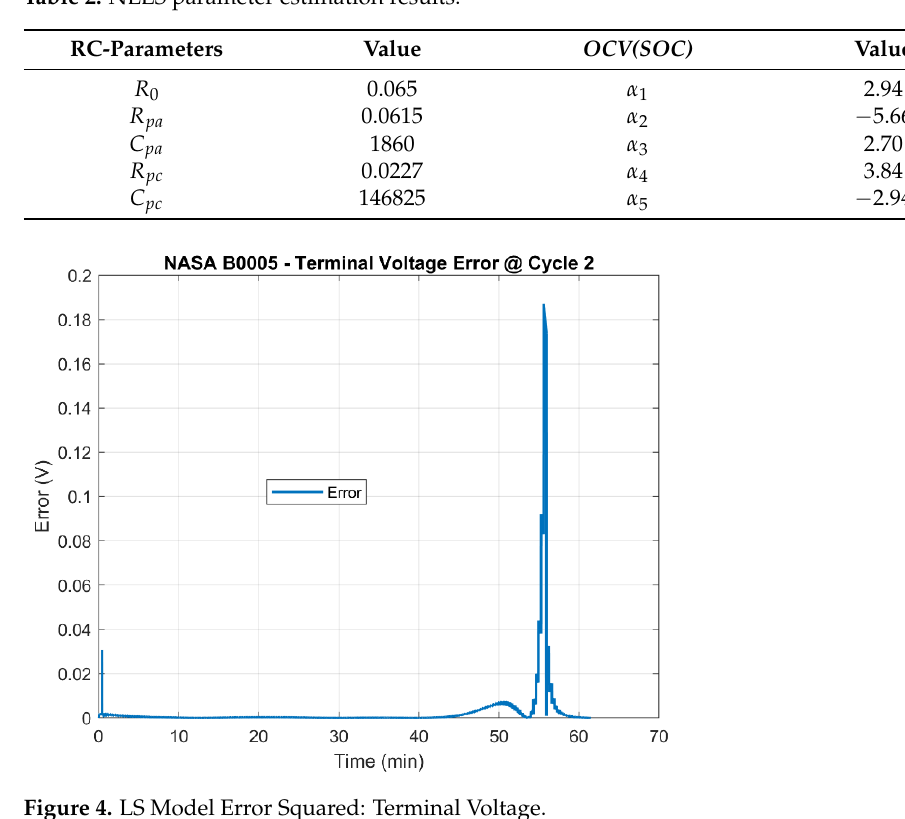
Table 2. NLLS parameter estimation results.